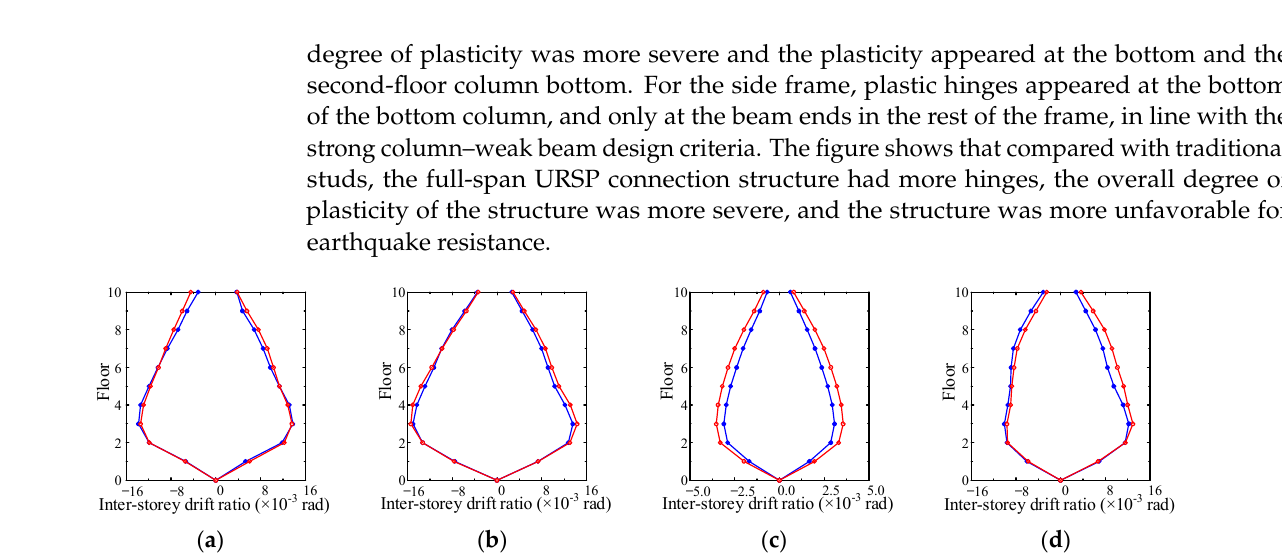
Figure 12. Inter-story drift ratio envelopes: ( a ) case XL1; ( b ) case YL1; ( c ) case YS1; ( d ) case XL2.